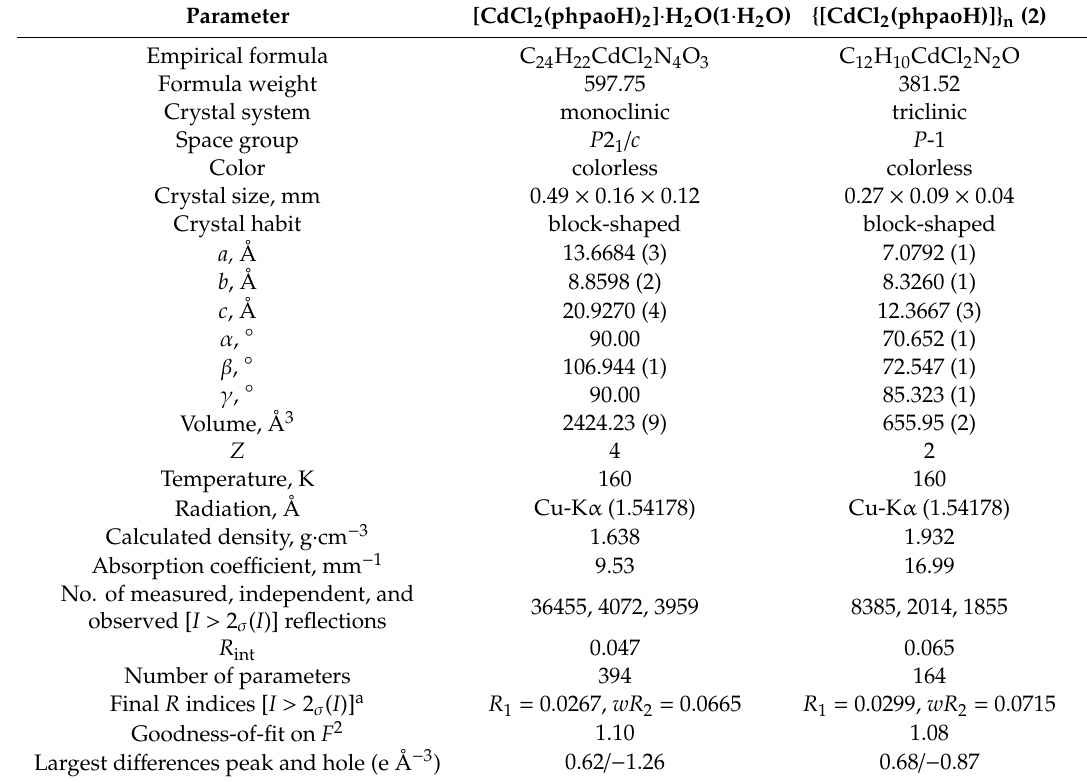
Table 1. Crystallographic data and structural refinement parameters for complexes 1 and 2 .